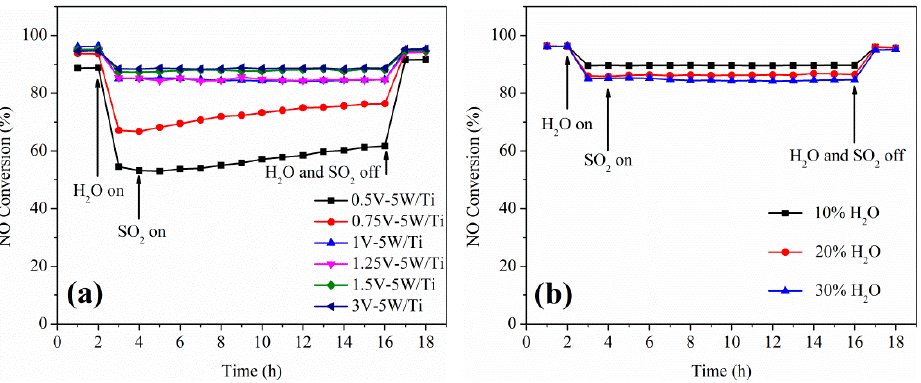
Figure 2. Effect of H 2 O and SO 2 on the NO conversion over the catalysts: ( a ) ( x )V-5W/Ti with different V 2 O 5 loadings; ( b ) effect of H 2 O concentration on 1V-5W/Ti catalyst. Reaction conditions: [NH 3 ] = [NO] = 400 ppm, [O 2 ] = 0.5%, [SO 2 ] = 200 ppm, [H 2 O] = 10%, 20%, 30%, balance N 2 , GHSV = 30,000 h − 1 , reaction temperature = 300 °C.